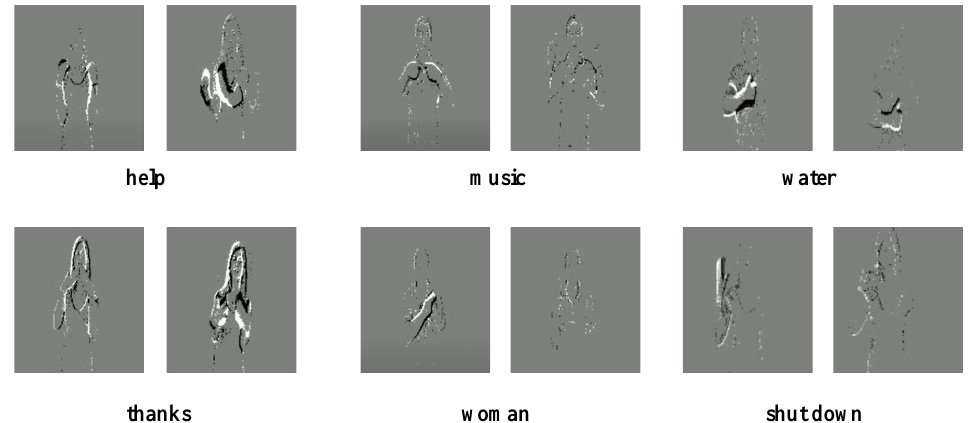
Figure 2. Part of the visual display of DVS_Sign language gesture dataset, each vocabulary example selects 2 grayscaled event video